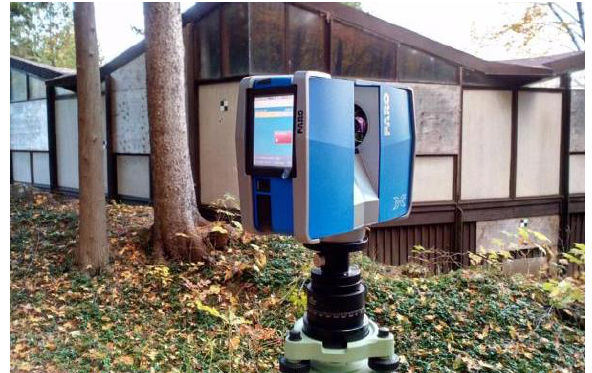
Figure 6. Laser scanning the building with a Faro Laser Scanner Focus3D X330 (above) Photo: Pierre Jouan.